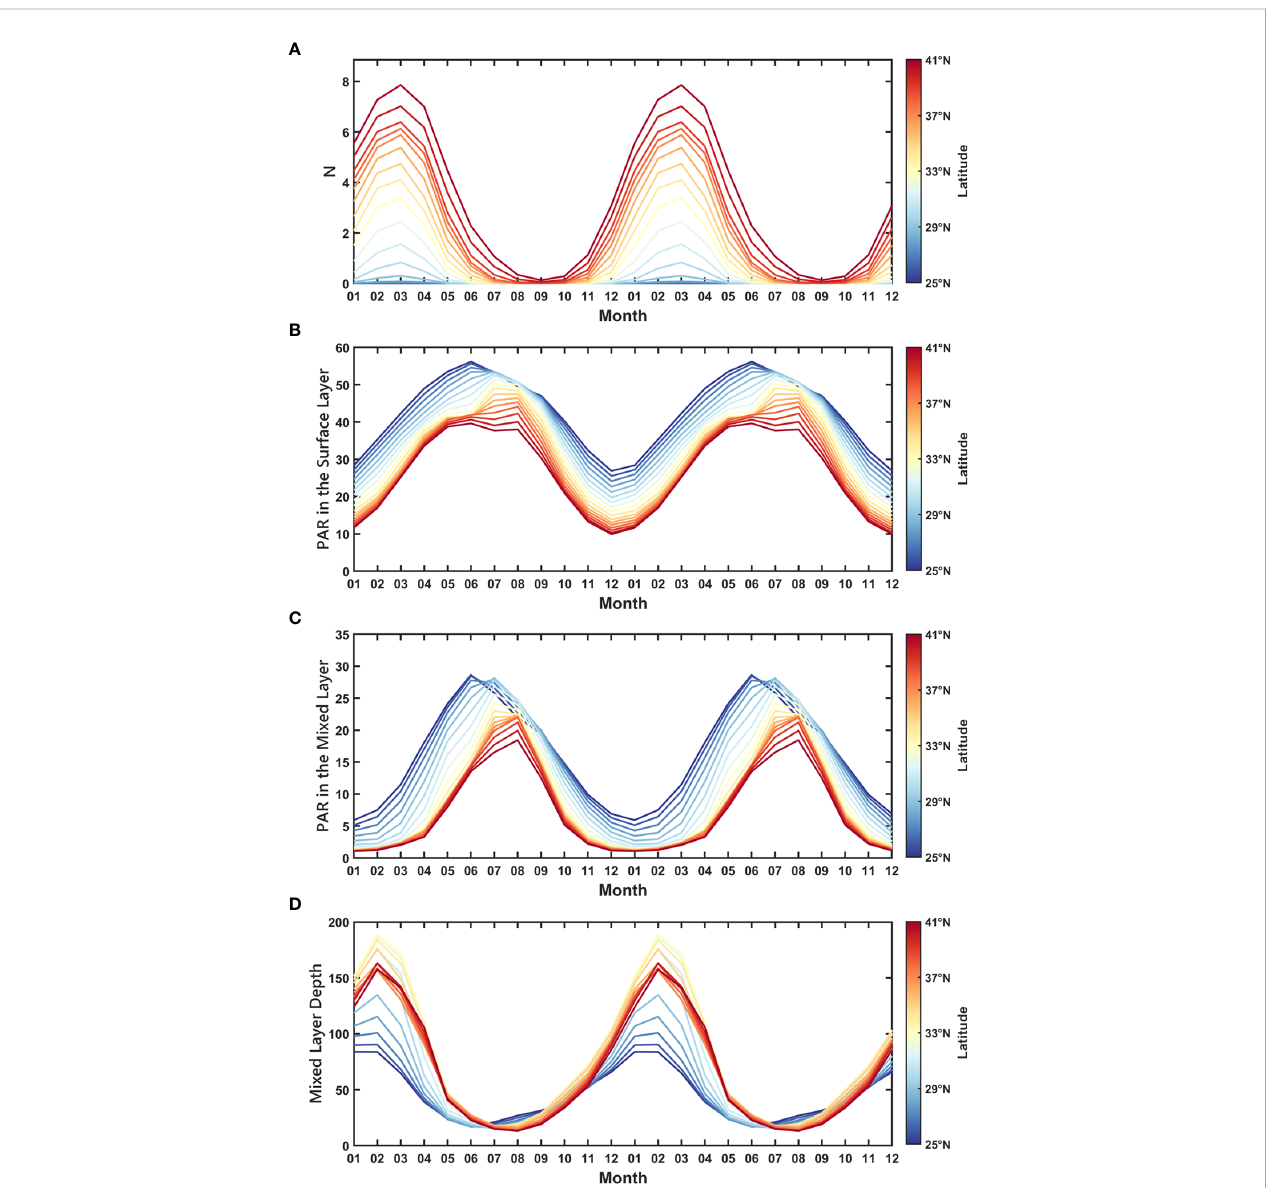
FIGURE 3 Seasonal cycle of (A) N, (B) PAR in the surface layer, (C) PAR in the mixed layer, and (D) Mixed Layer